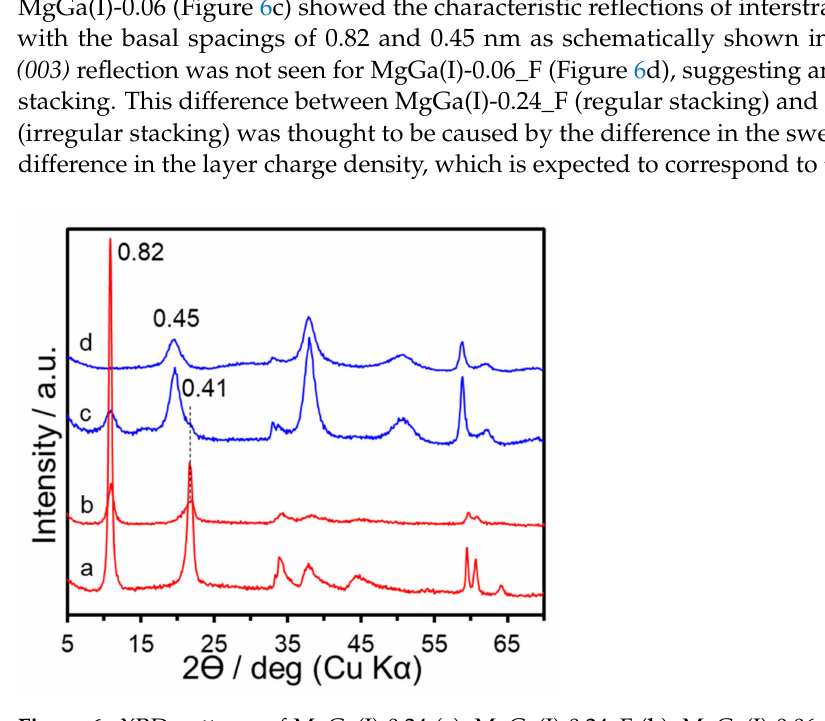
Figure 6. XRD patterns of MgGa(I)-0.24 ( a ), MgGa(I)-0.24_F ( b ), MgGa(I)-0.06 ( c ), and MgGa(I)- 0.06_F ( d